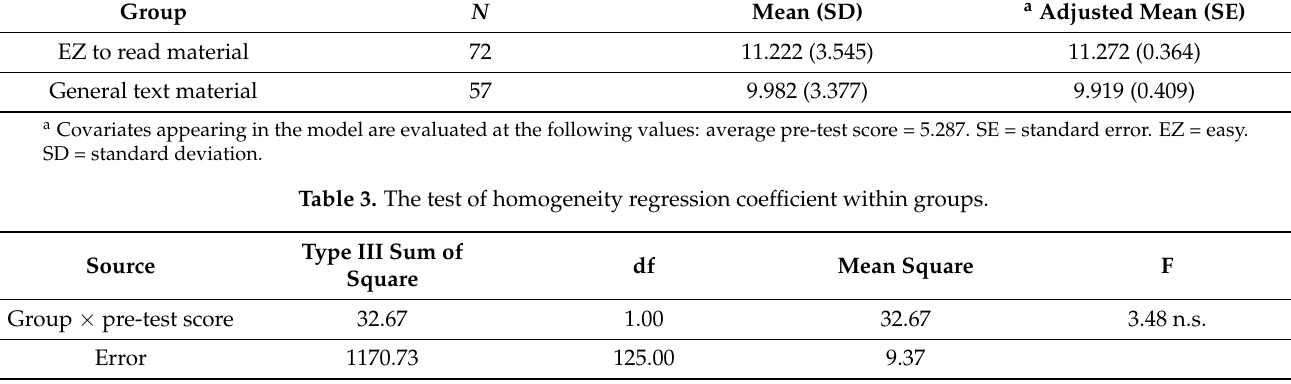
Table 2. Descriptive statistics data of the MOHL-AQ post-test score between groups using different materials. Group